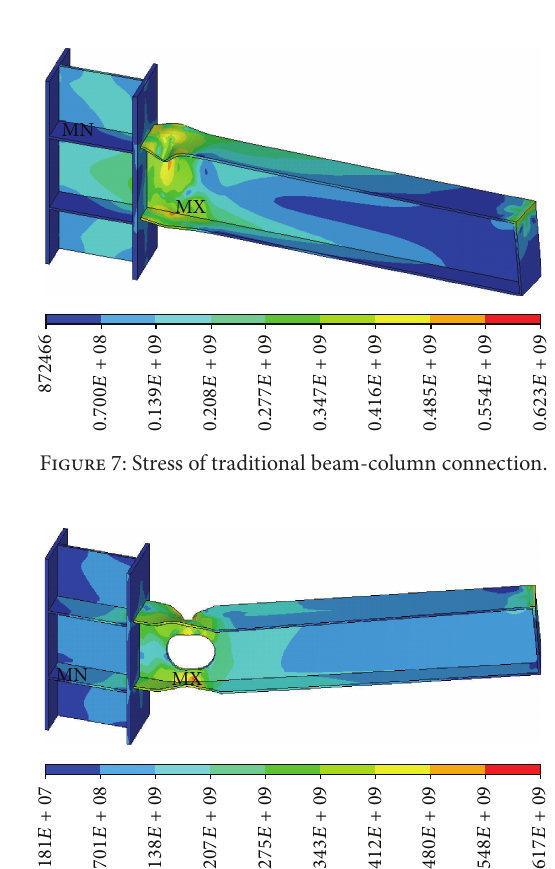
controlled by displacement and the loading increases by step from the initial state. The displacement increment of each level is 12 mm, two cycles are carried out for each level, and 12 levels are finally applied until the member damage with severe buckling or obvious deformation. The equivalent stress contours of the different connections when the displacement of the beam end reaches 144 mm are shown in Figures 7–10, respectively.